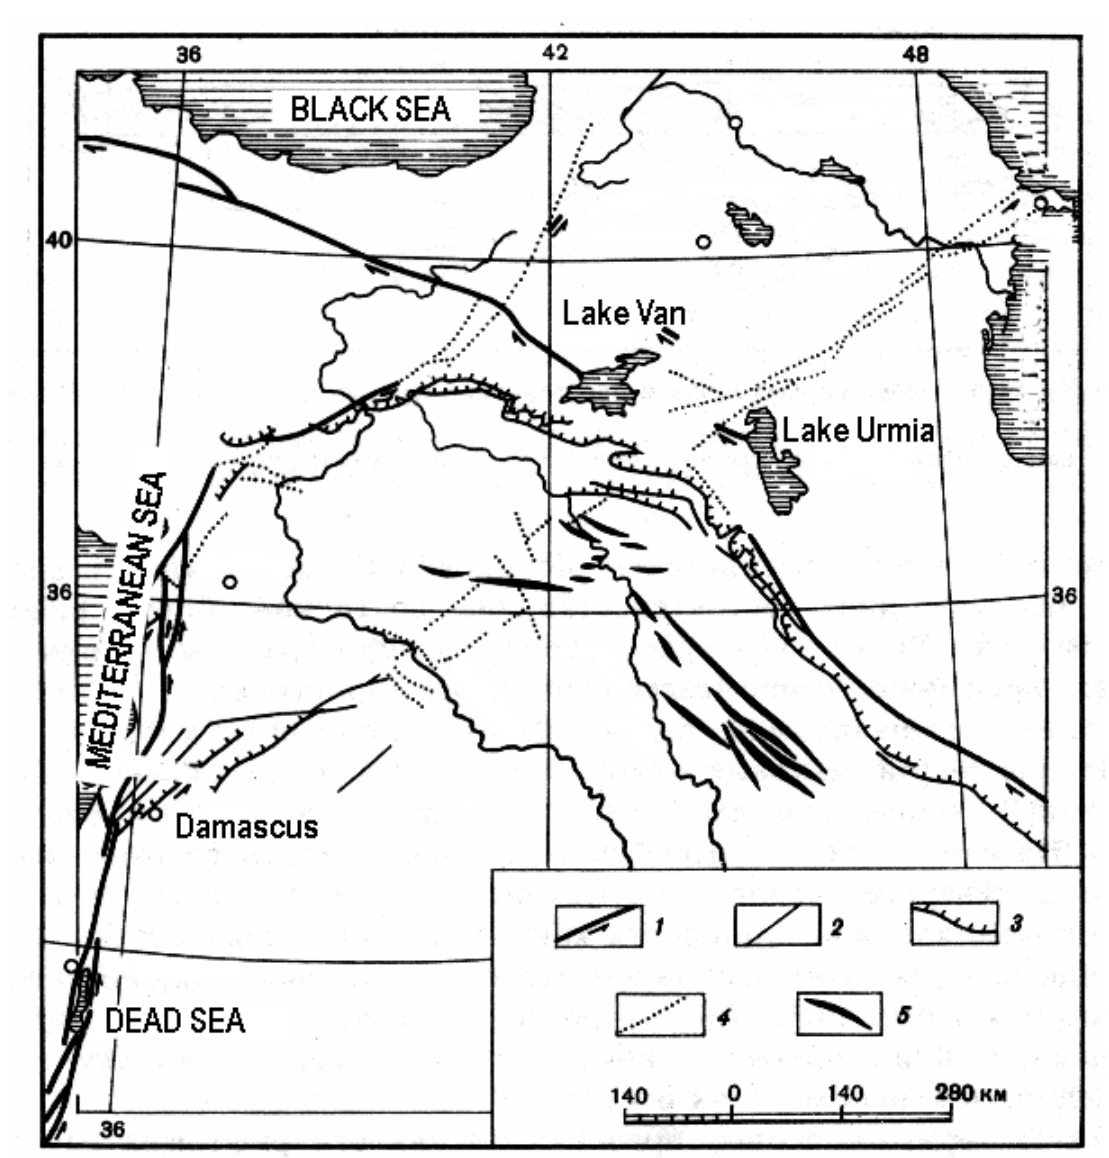
Figure 1. Main fault systems of North Arabian plate [10]:1 ― active faults; 2 ― late Cenozoic faults; 3 ― Cenozoic thrusts; 4 ― alignment on the base of satellite images; 5 ―